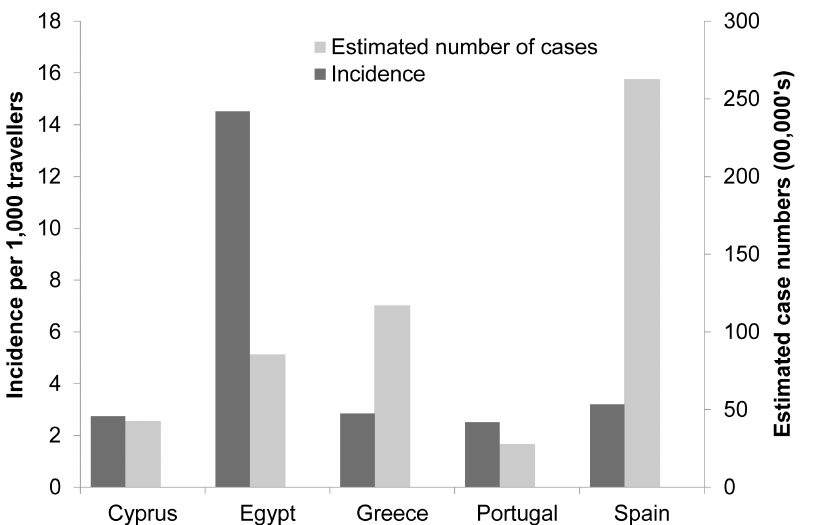
Figure 3. Incidence and estimated number of cases of stomach upset in travellers (both cruise- and land-based) in the period from Jan 2001 to Dec 2008.